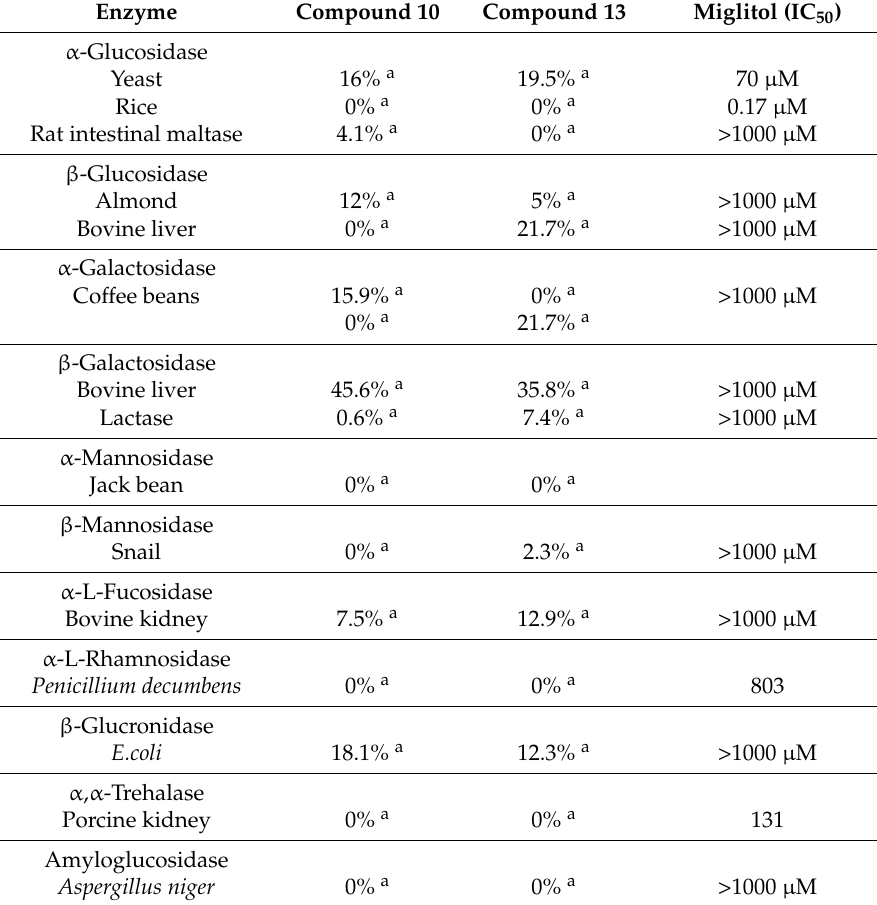
Table 1. Data on inhibition of various glycosidases by compounds 10 and